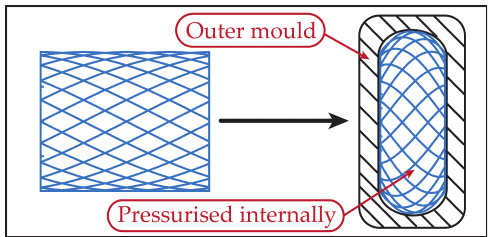
Figure 2: The curing process of spherical fiber reinforced rubber